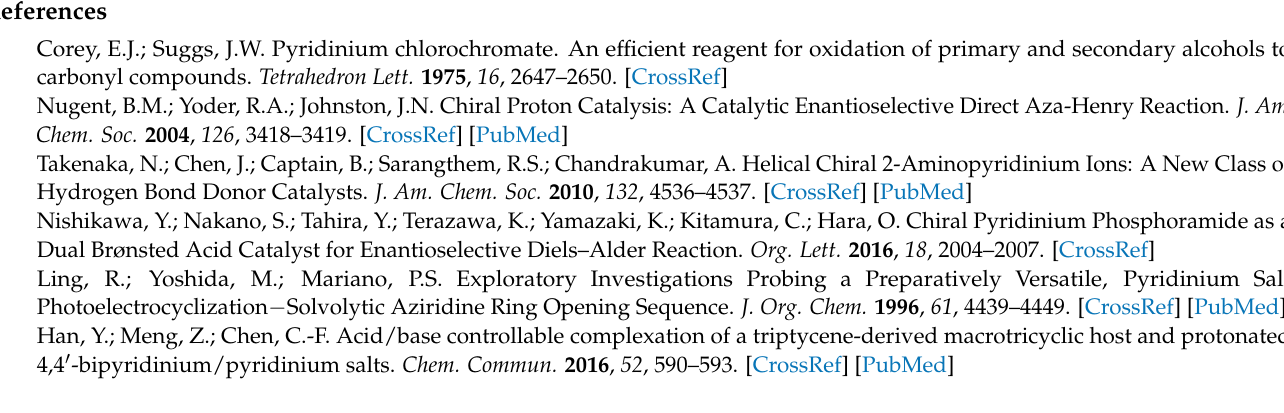
Figure S3. 19 F{ 1 H} NMR spectrum (CDCl 3 , 376 MHz) of compound 2